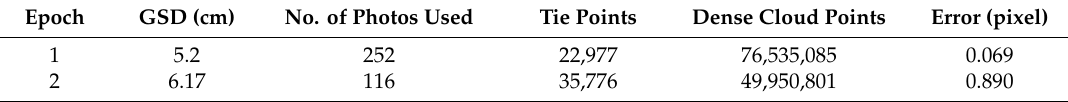
Table 4. Assessment of the image geo-referencing error from GCPs for both